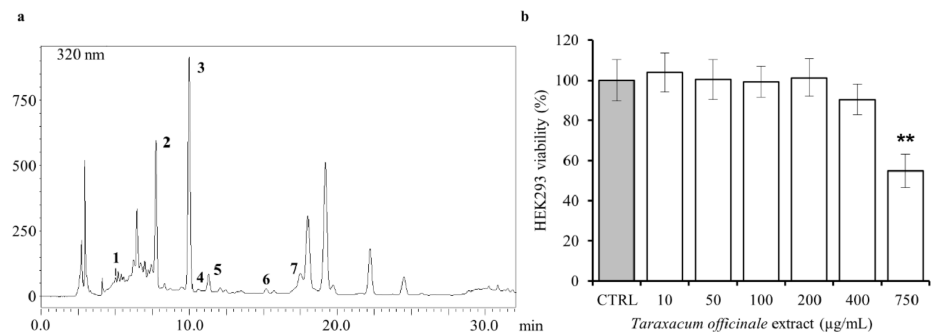
Figure 1. HPLC analysis of dandelion root extract (DRE) and evaluation of its cytotoxicity. ( a ) Chromatogram obtained by HPLC analysis of a Taraxacum officinale root extract at 320 nm. The compounds identified are gallic acid (1), chlorogenic acid (2), caffeic acid (3), vanillic acid (4), syringic acid (5), p-coumaric (6), and ferulic acid (7). ( b ) Viability of HEK293 cells cultured in the absence (ethanol 0.6% as control, CTRL) and presence of diverse doses of T. officinale root extract for 24 h by Calcein viability assay. The reported values are means ± SEM of three independent experiments (** p < 0.01 vs.